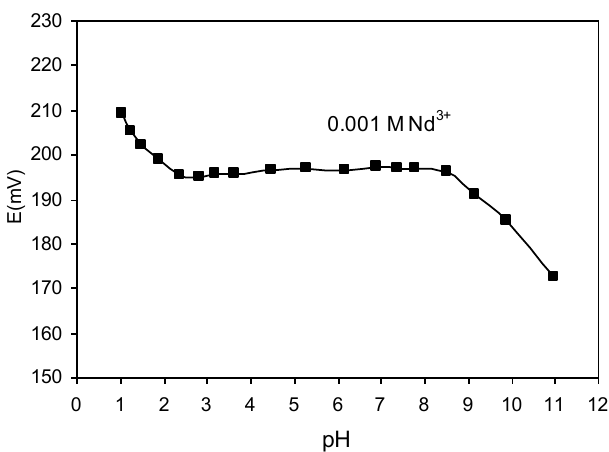
Figure 3. The pH effect of the test solution on the potential response of the neodymium sensor.